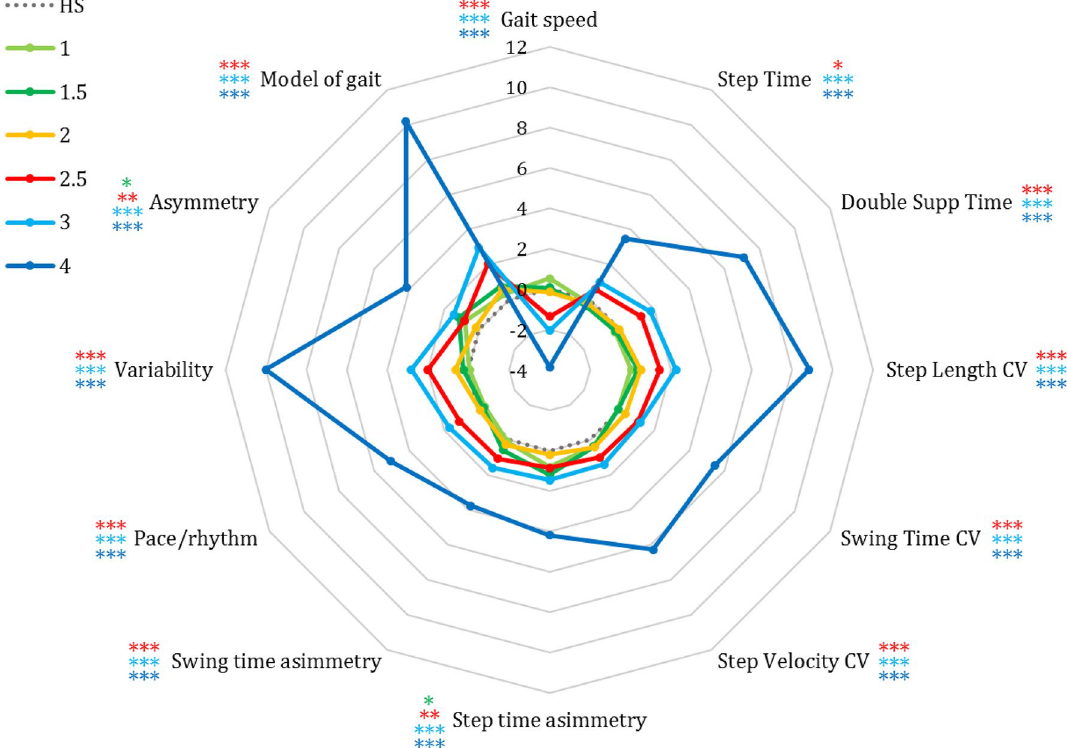
Figure 3. Radar plot illustrating the z-scores of pwPD and HS for the 8 gait variables, 3 factor scores and overall gait model. The grey dashed line passing through zero represents the z-scores data of HS, while the other coloured lines represent the z-scores data of the six H&Y stages of pwPD. The values on the axis indicate how often the z-scores for each variable, factor or model obtained by pwPD at the different H&Y stages differ from the corresponding data of HS. Coloured asterisks represent significant differences between each gait variables, factor scores and overall gait model of HS compared to those of pwPD at different stages: *p < 0.05; **p < 0.005; ***p < 0.0005. In particular, the asterisks coloured in dark green, red, light-blue and dark blue represent the differences of HS with pwPD at stages 1.5, 2.5, 3 and 4, respectively.